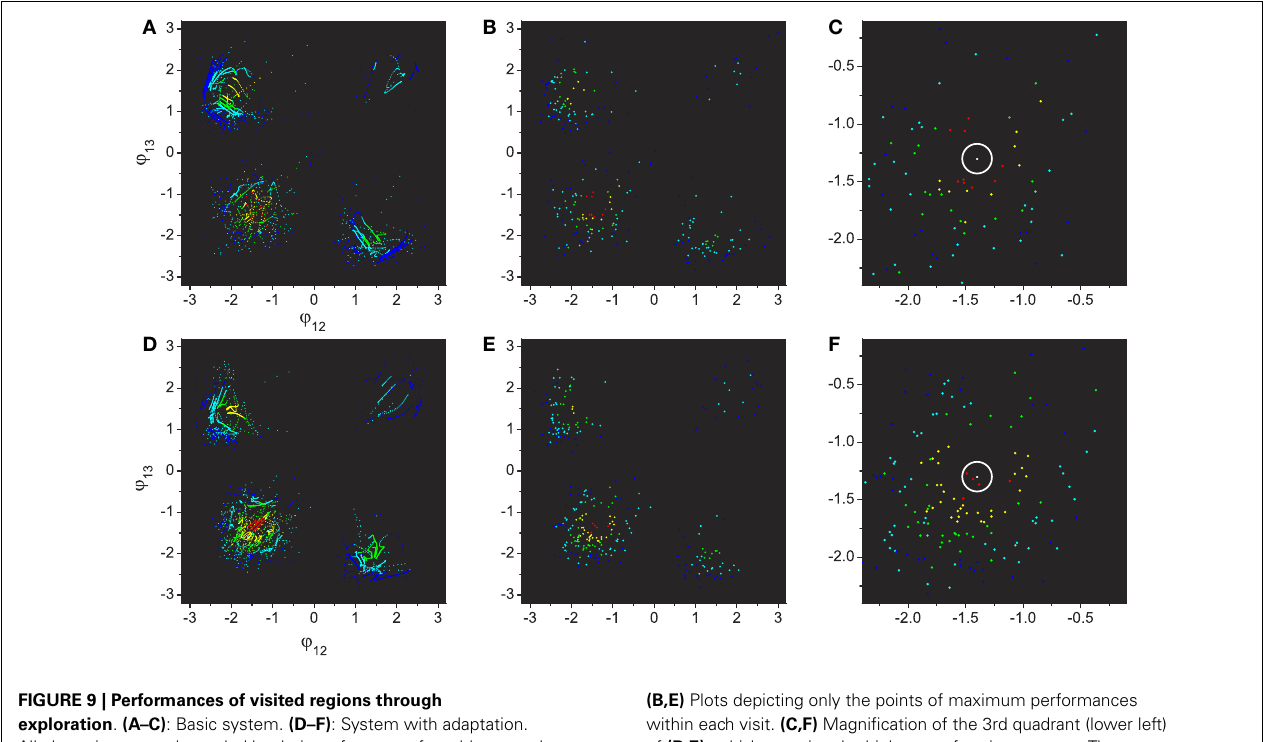
(B,E) Plots depicting only the points of maximum performances within each visit. (C,F) Magnification of the 3rd quadrant (lower left) of (B,E) , which contains the highest performing patterns.The center of the white circle is the highest performance ( E = 1.0) defined in the phase